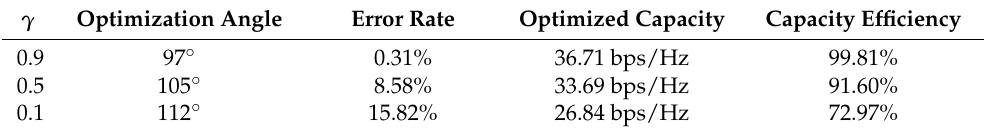
Table 12. Optimized values for antenna downtilt and channel capacity with different discount rates at D = 200 m.